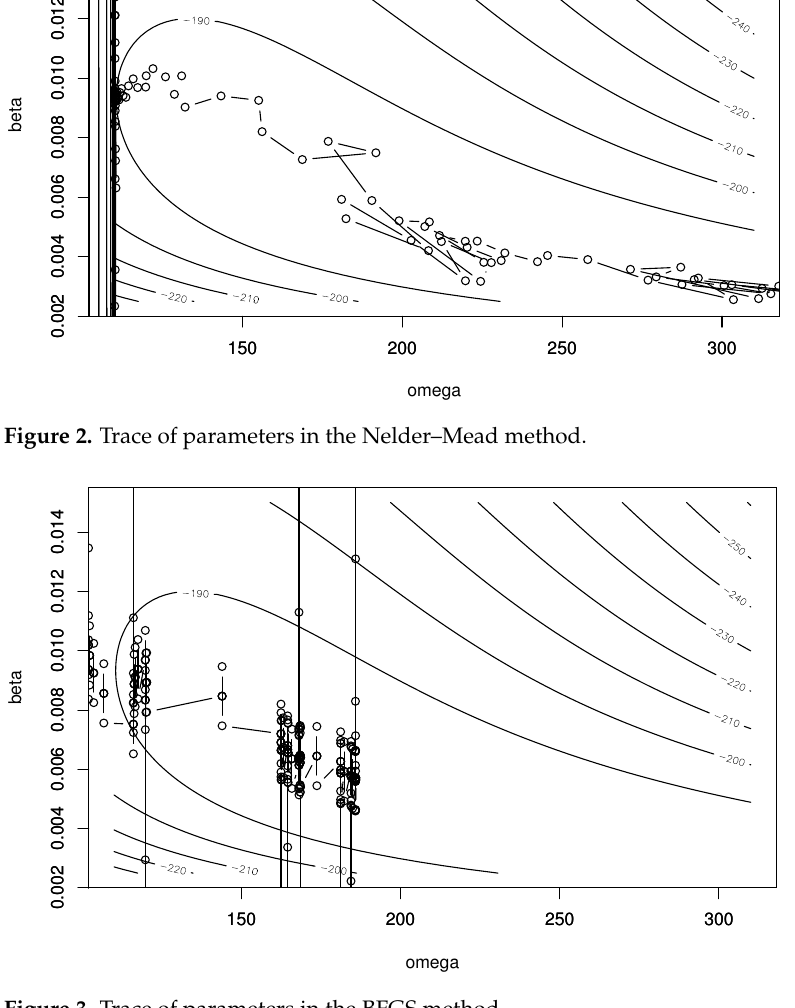
Figure 3. Trace of parameters in the BFGS